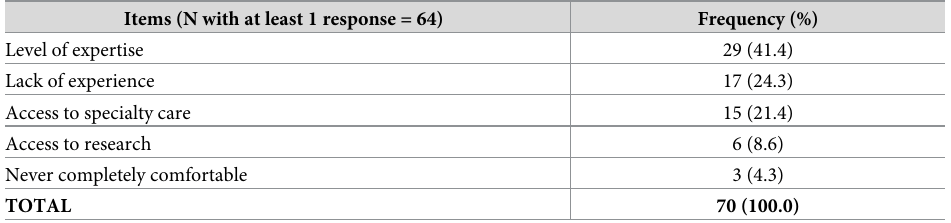
Table 7. Factors in determining comfort level of providing care for patients with headache following concussion. Items (N with at least 1 response =